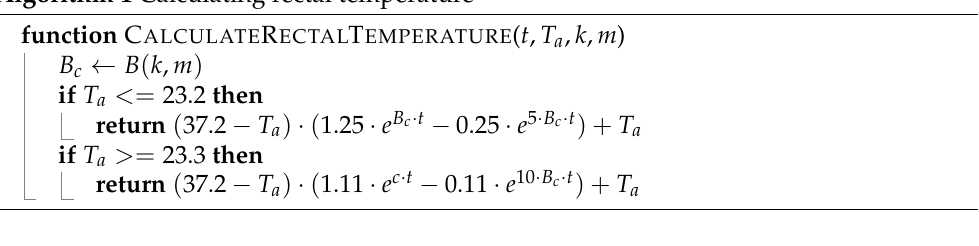
Algorithm 1 Calculating rectal temperature